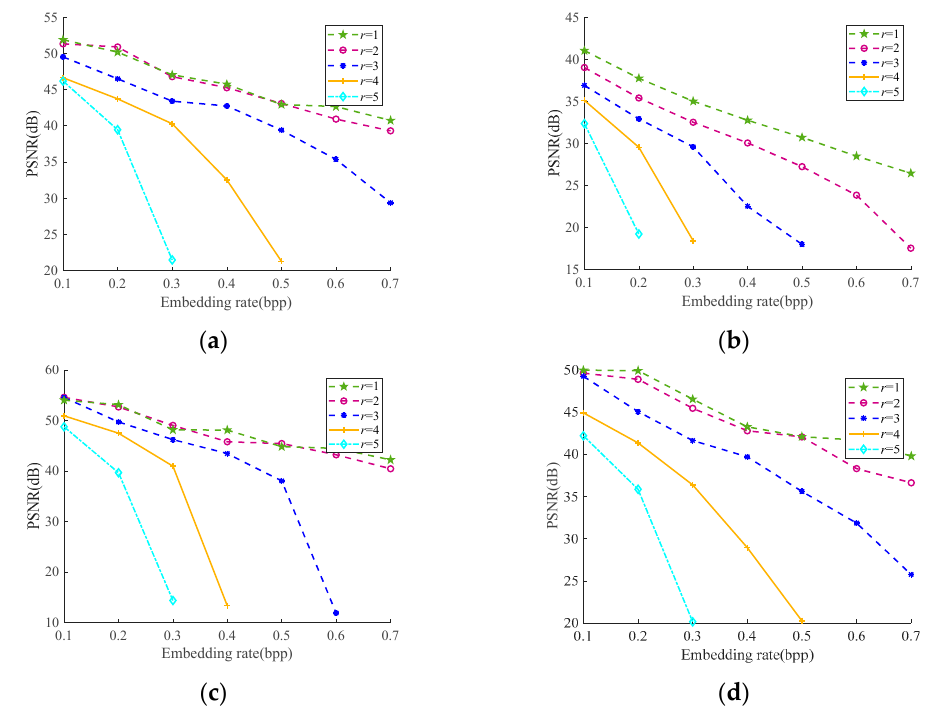
Figure 8. The effect of r on the capacity–distortion performance: ( a ) Lena; ( b ) Baboon; ( c ) Airplane; and ( d ) Boat.